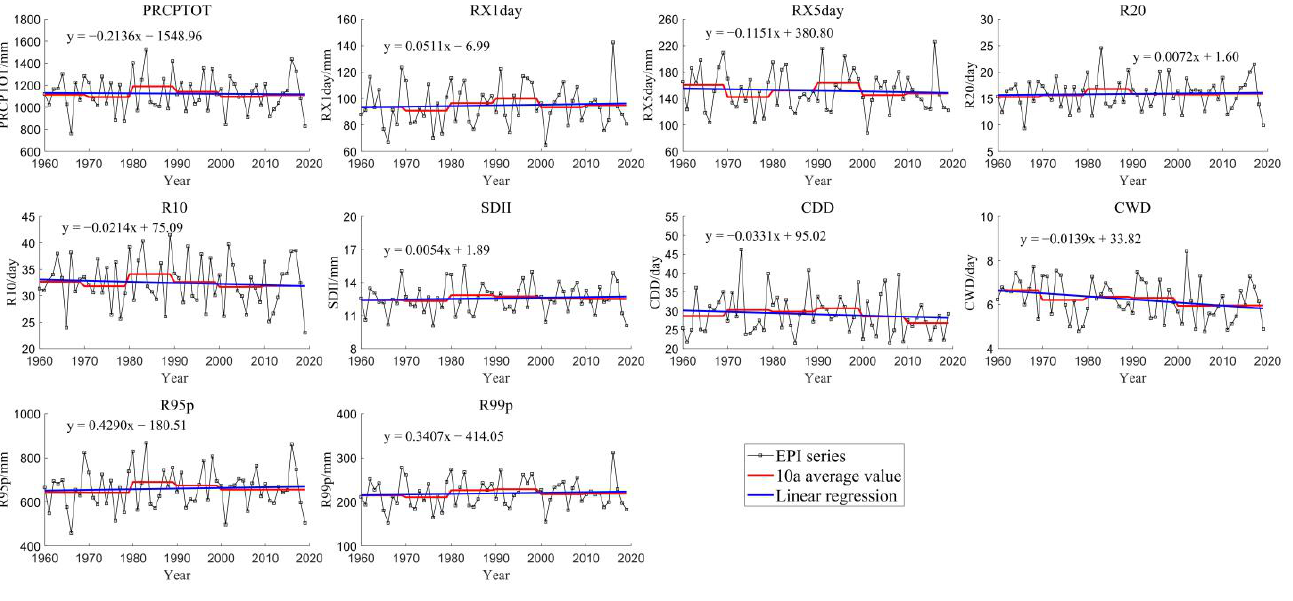
Figure 2. Trend and 10a average value of EPIs within Hubei province on the annual scale during 1960–2019. Table 3. Statistic of change trend of each EPI within Hubei province on the annual scale during 1960 – 2019.